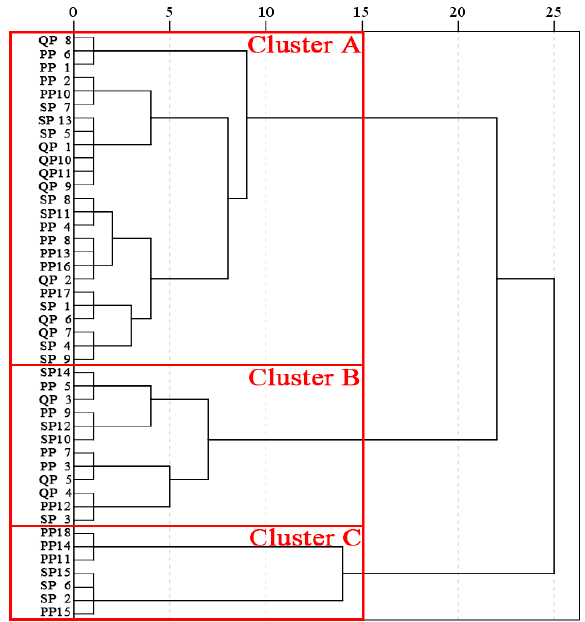
Figure 5. Hierarchical cluster analysis (HCA) of subjective and objective variations of soundscape and lightscape.